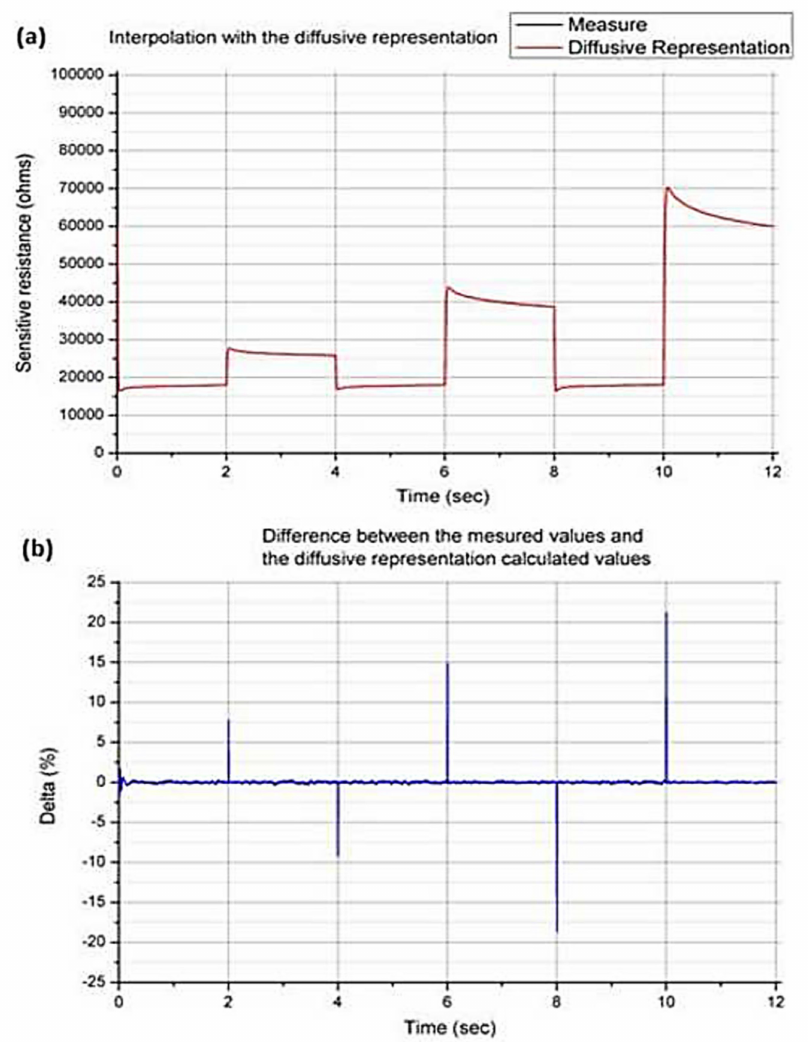
Figure 10. Comparison between the sensor’s response and the diffusive representation modeling ( a ) and difference between both ( b